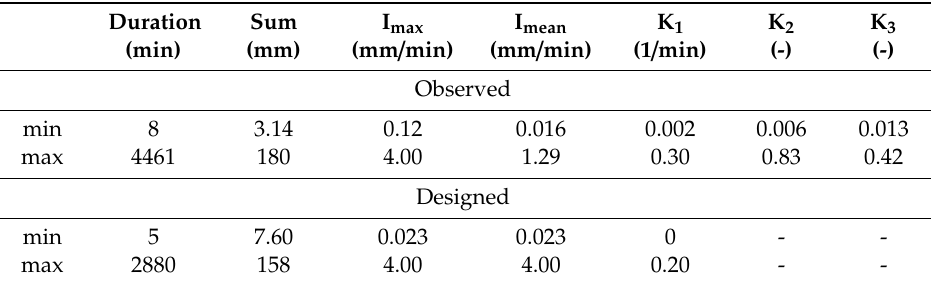
Table 5. Overview of the input precipitation.